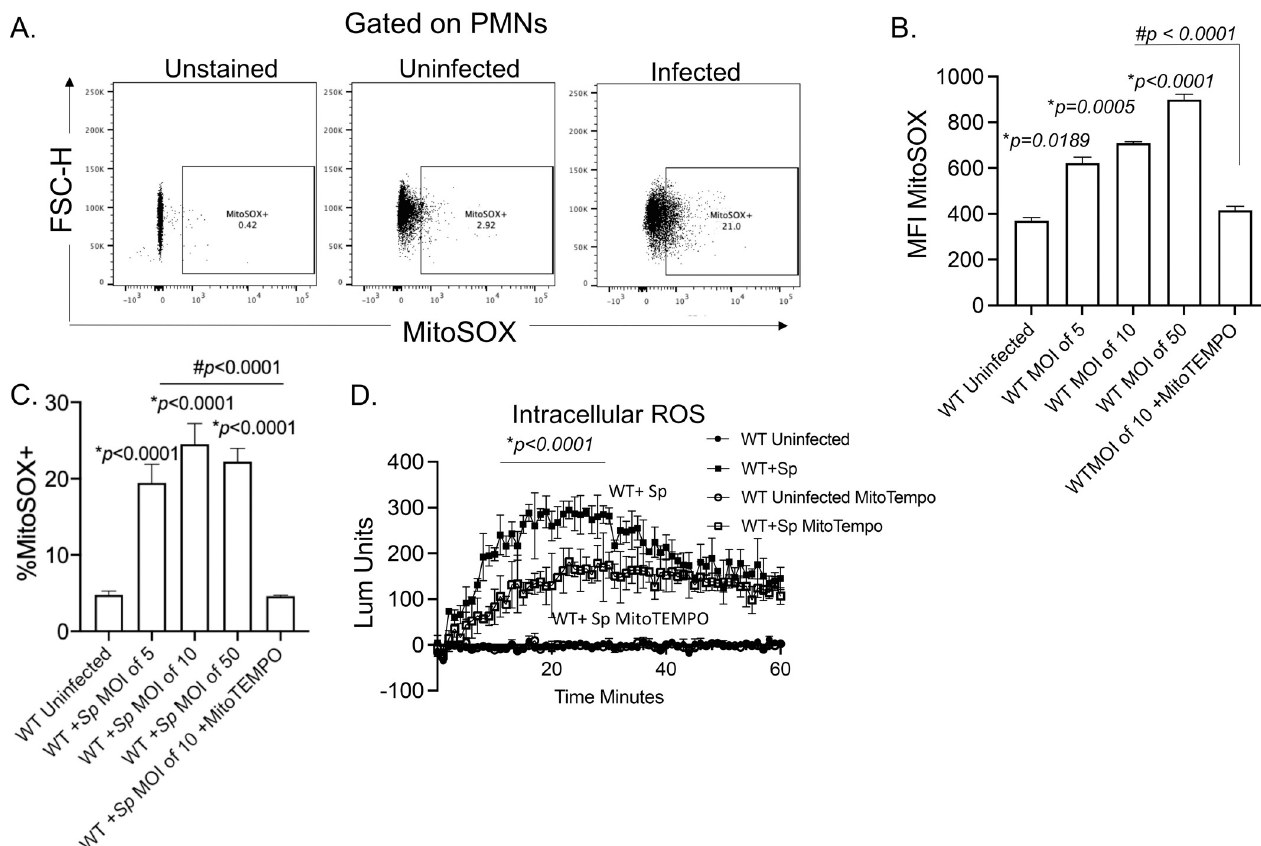
Fig 1. Mitochondrial ROS are produced by PMNs in response to Streptococcus pneumoniae infection. WT (C57BL/6) bone marrow-derived PMNs were infected with S . pneumoniae TIGR4 at various MOIs for 10 minutes and mitochondrial ROS measured using MitoSOX. (A) Gating strategy. (B) The geometric Mean Fluorescent Intensity (MFI) or (C) % of mitochondrial ROS producing cells were determined by flow cytometry. (D) PMNs were treated with vehicle control or the mitochondrial ROS scavenger MitoTEMPO and then mock treated (uninfected) or infected with S . pneumoniae (+Sp) TIGR4 at a MOI of 50. Cells were monitored for intracellular ROS production over the course of 60 minutes using chemiluminescent luminol. (B-D) Representative data shown are from 1 out of 5 separate experiments in which n = 3 technical replicates were used per condition. Line and Bar graphs represent the mean +/-SD. (B and C) � indicates significant differences from uninfected controls and # indicates significant differences between the indicated groups as measured by one-way ANOVA followed by Tukey’s multiple comparison test. (D) � indicates significant differences between infected groups +/- MitoTEMPO as determined by 2-way ANOVA followed by Tukey’s multiple comparisons